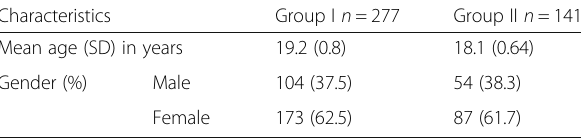
Table 1 Profile of study participants - undergraduate medical students from Madurai, India in 2016 ( n = 418) Characteristics